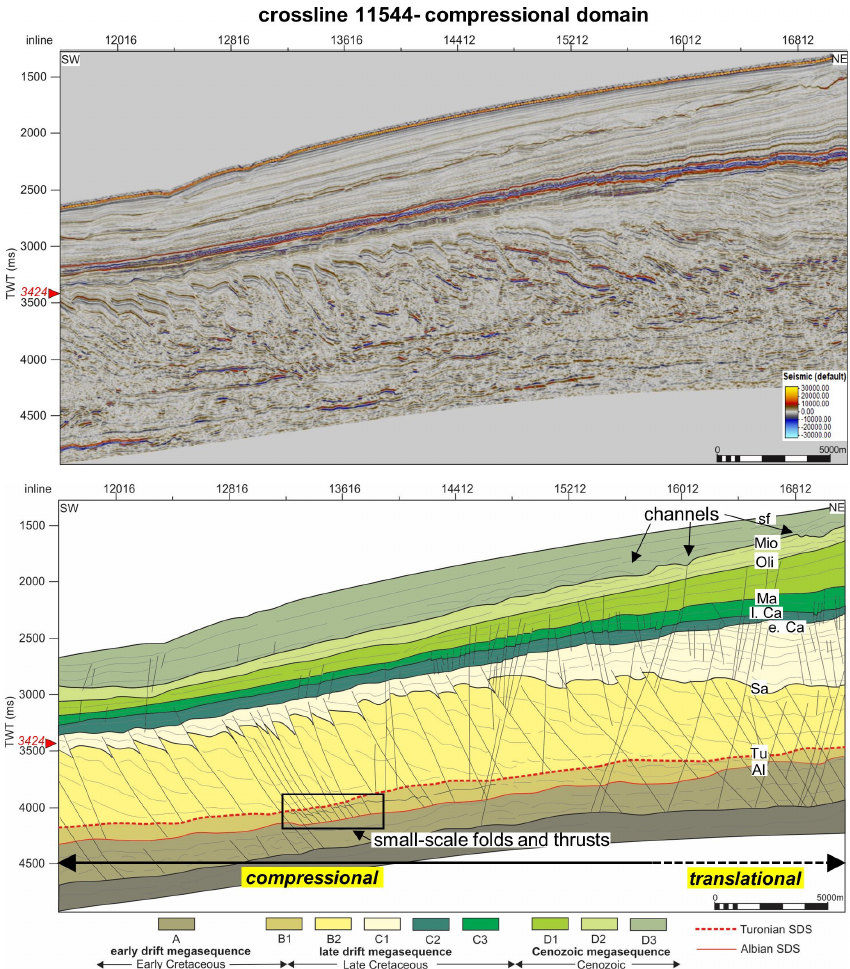
Figure 6. Uninterpreted and interpreted sections of crossline 11544 showing a portion of the translational and compressional domains and position of time slice 3424. The crossline lies roughly perpendicular to the compressional domain DWFTBs giving a view of their structure in comparison to the translational domain. Abbreviations: Al – Albian; Tu – Turonian; Sa – Santonian; Ma – Maastrichtian; Oli –